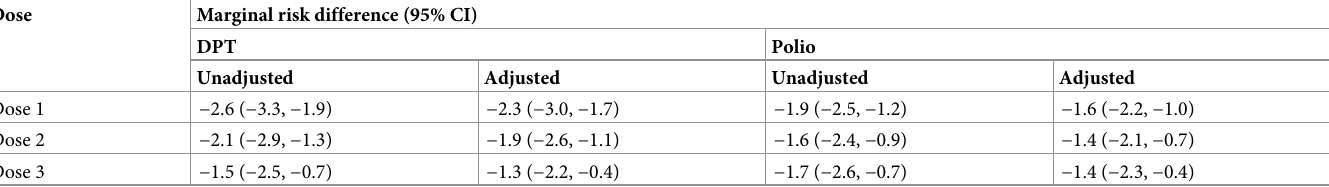
Table 4. Adjusted associations between drought at date of birth and each dose of DPT and polio